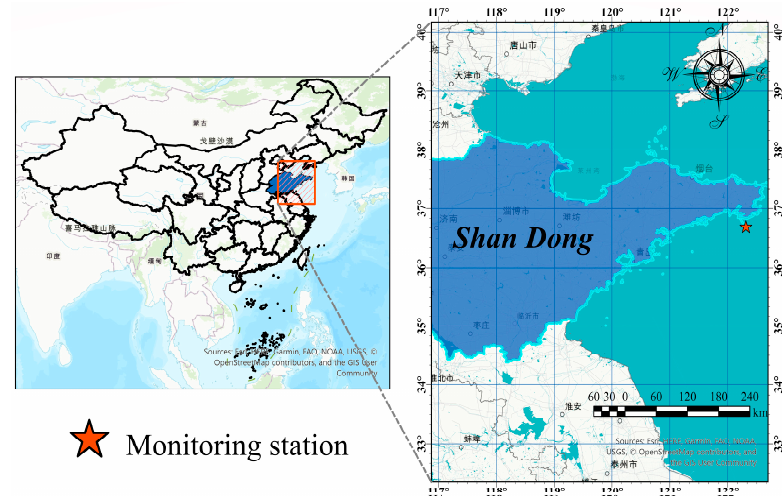
Figure 3. Distribution of ShiDao monitoring station on the east coast of China.